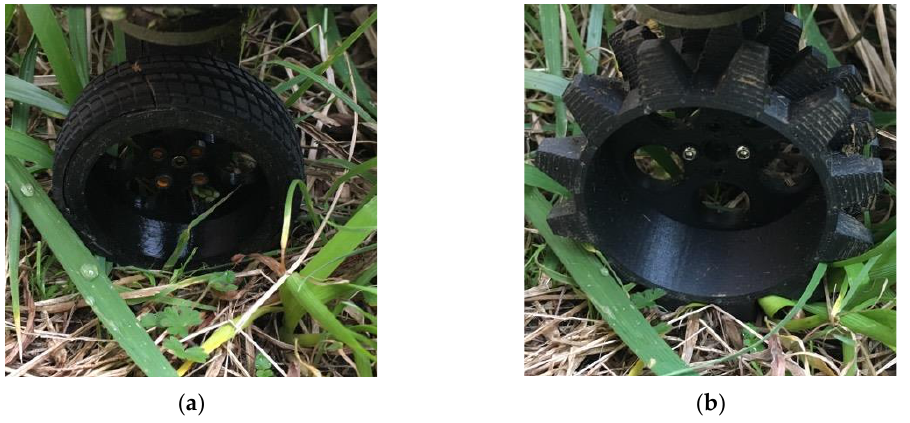
Figure 12. Wheels on grassy terrain. Wheel diameters are 60 mm, and the spike length is 10 mm. ( a ) Normal wheel. ( b ) Spiked wheel.